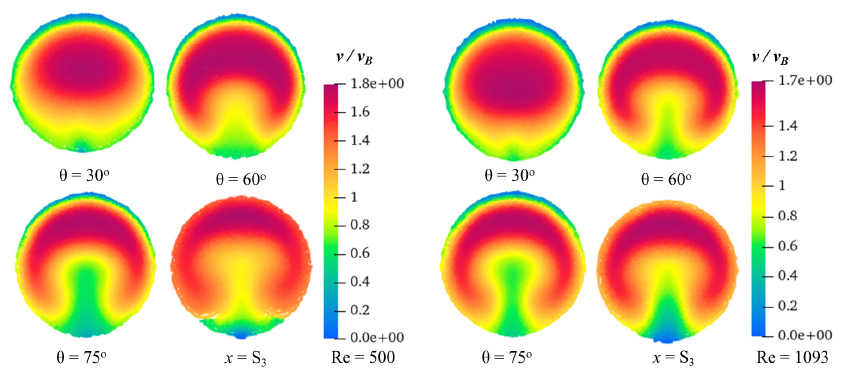
Figure 6. Cross-sectional streamwise velocity maps at planes θ = 30 ◦ , 60 ◦ and 75 ◦ through the bend and S 3 = 1 D downstream of the bend outlet for Re = 500 ( left ) and Re = 1093 ( right ). The numbers on the color bars indicate the values of the streamwise velocity normalized to v B